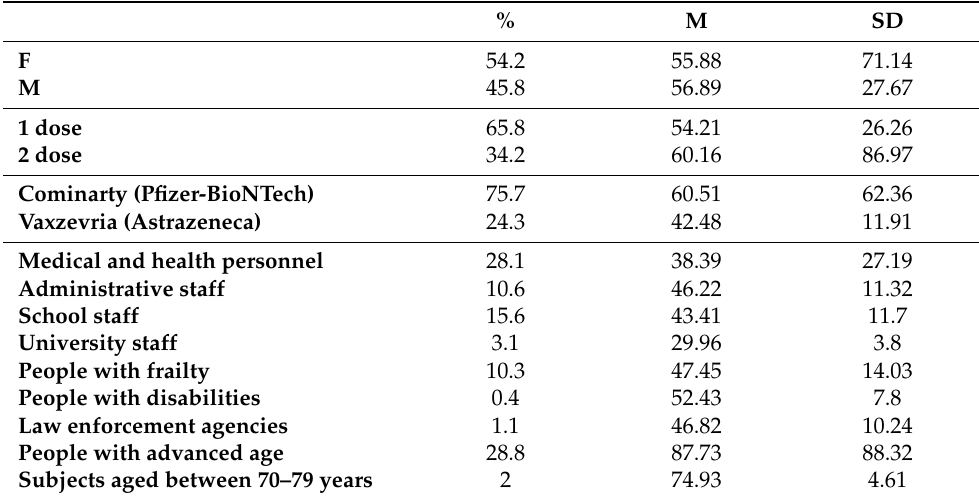
Table 1. Frequencies in percentage (%), mean age (M) and standard deviation (SD) of the characteris- tics of the sample of